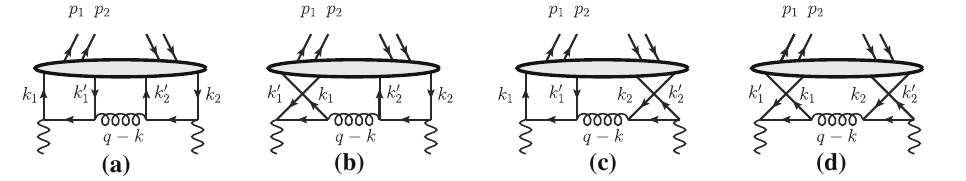
= k − k and k (cid:4) = k − k ; in 1 2 1 2 and k 2 with 1